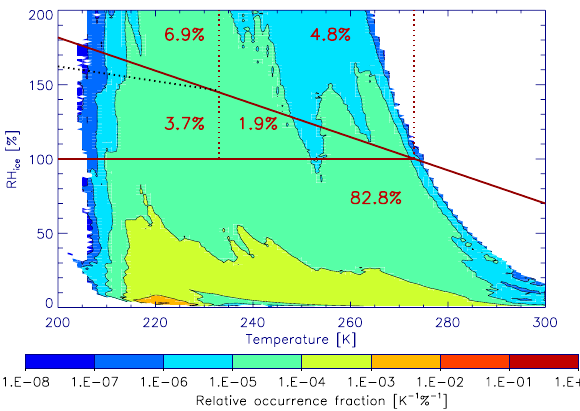
Fig. 8. The fraction of all 90 million trajectory points with a partic- ular RH ice and temperature (normalised) from trajectories leaving the Eyjafjallaj¨okull region between 15 and 30 April 2010. RH ice at each point is calculated using the water vapour mixing ratio from the initial trajectory point (see text). Red diagonal line: saturation with respect to liquid water (RH liq = 100%). Red horizontal line: RH ice = 100%. Black dashed line: homogeneous ice nucleation (Koop et al., 2000). Red dashed lines (at T = 233K and 273K): di- vision lines between warm clouds ( T > 273K), mixed-phase clouds (233K <T < 273K), and cold cirrus clouds ( T < 233K). The per- centage of the trajectory points in each segment surrounded by red lines is indicated by the red numerals. Note: points with RH > RH liq are indicative for condensation of liquid water (i.e. the trajectory will continue along the red diagonal). Compare Wiacek et al.